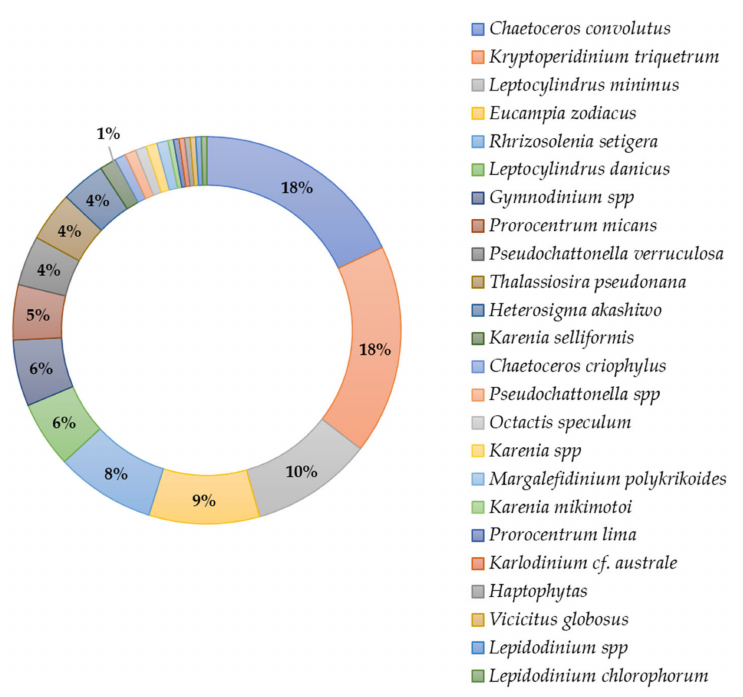
Figure 14. HABs species associated with harmful effects on farmed fish and mortality of other marine organisms.